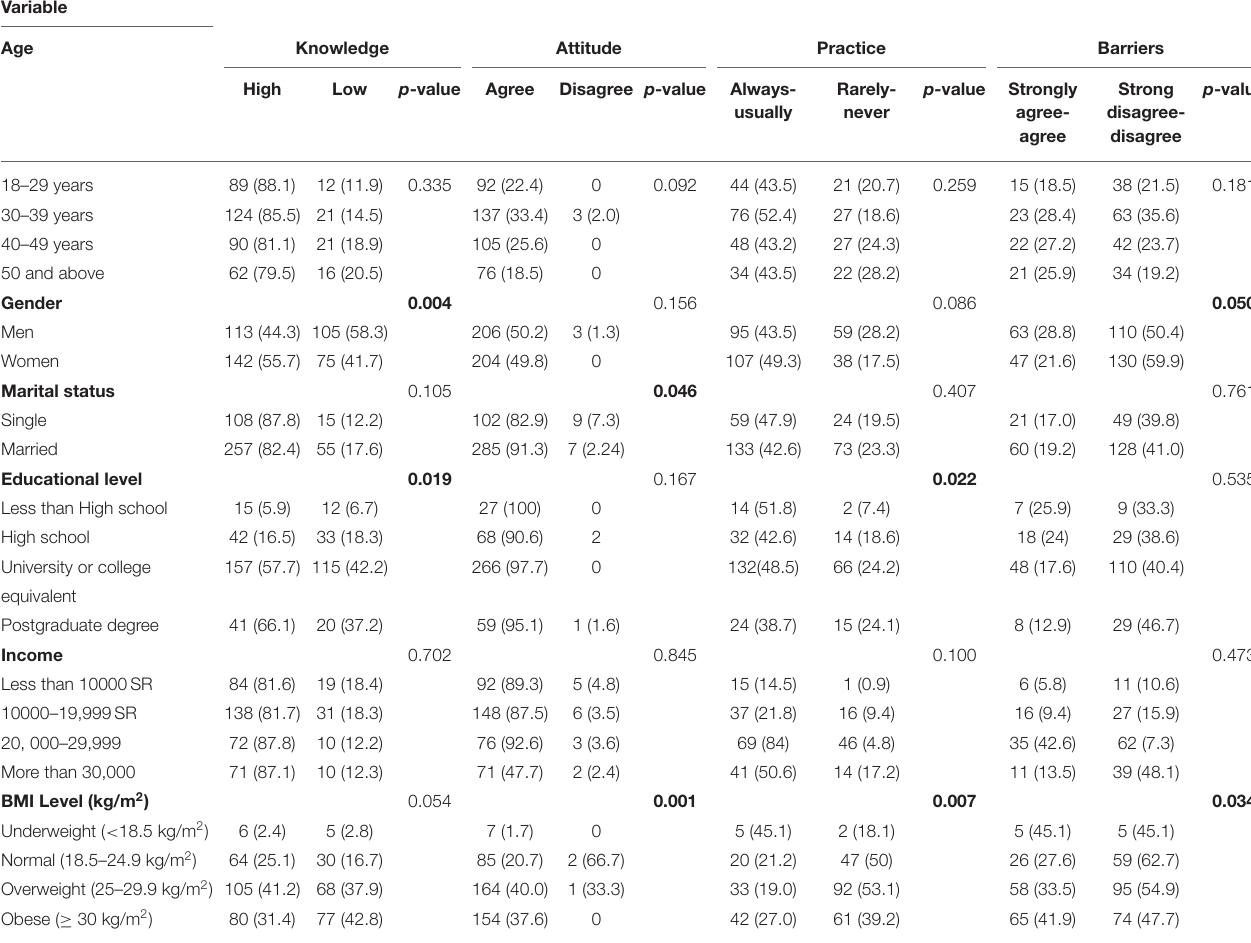
TABLE 3 | Association between participants’ knowledge, attitudes, and practices with demographic characteristics.